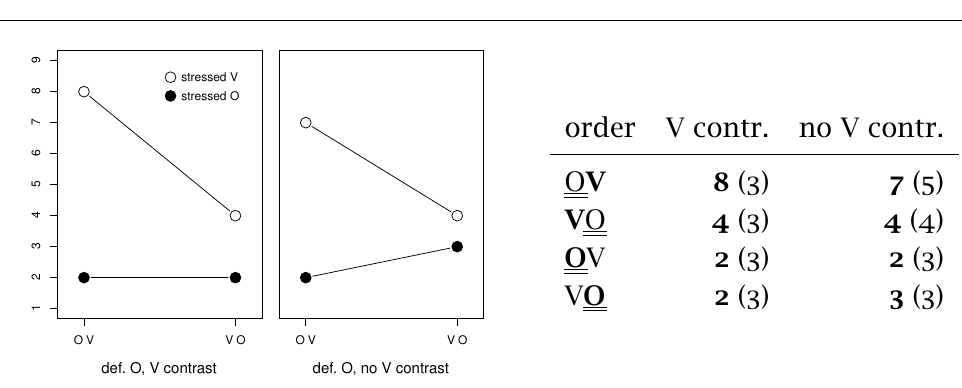
Figure 10 Results of the post-hoc analysis for salient verb contrast in the definite contexts; medians in boldface, IQR in